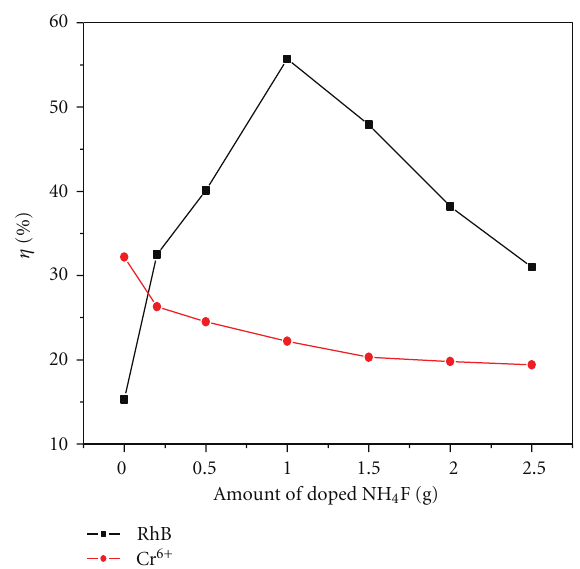
Figure 7: E ff ect of the amount of doped CuO on the photocatalytic reduction of Cr 2 O 72 − and photocatalytic oxidation of